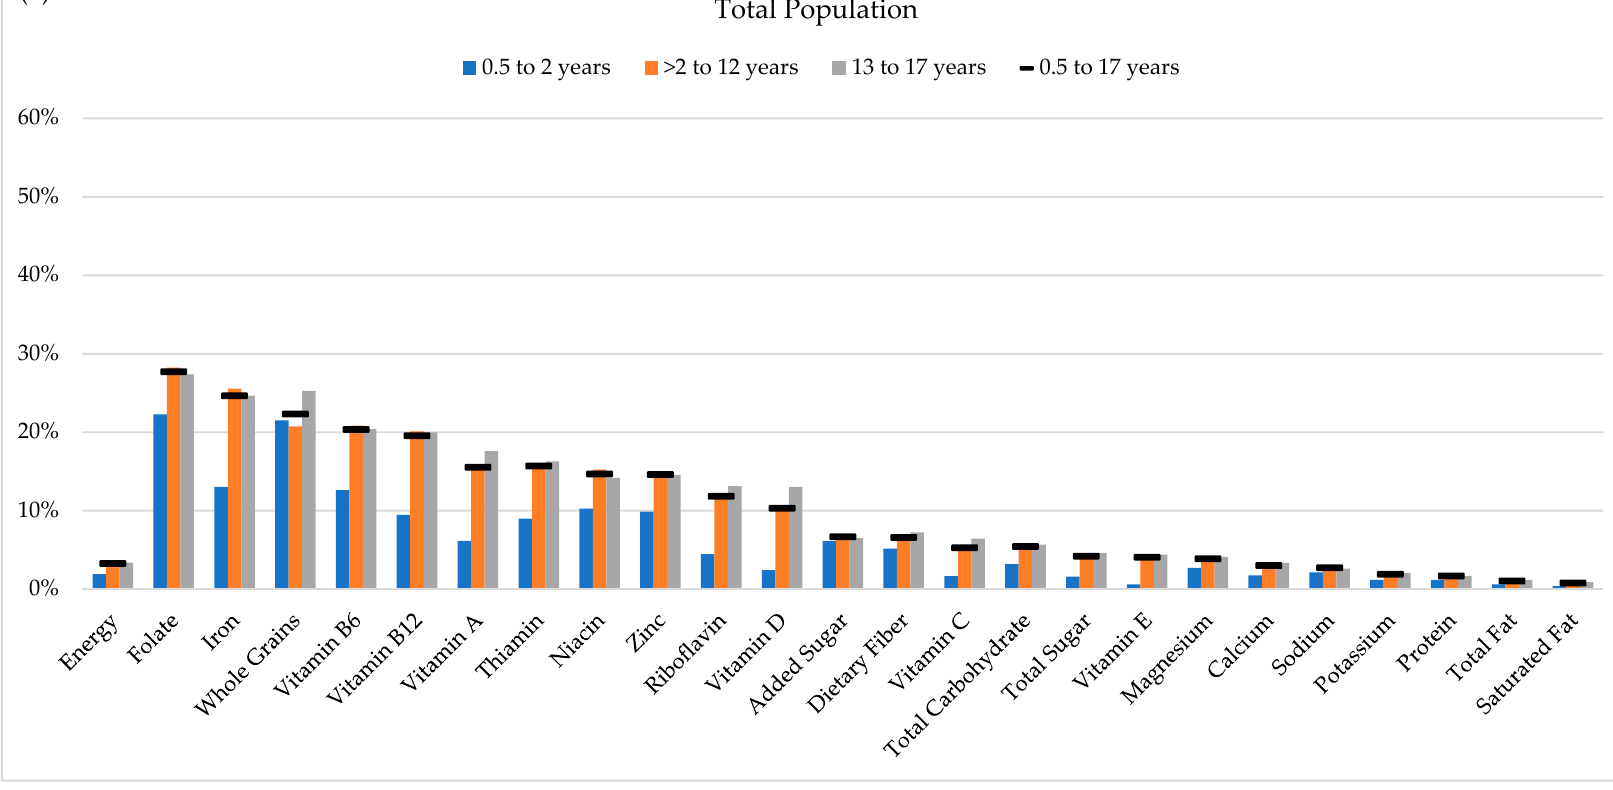
Figure 2. Percent Contribution of RTE cereal to daily intakes: ( a ) for RTE cereal eaters only and ( b ) for the total population.